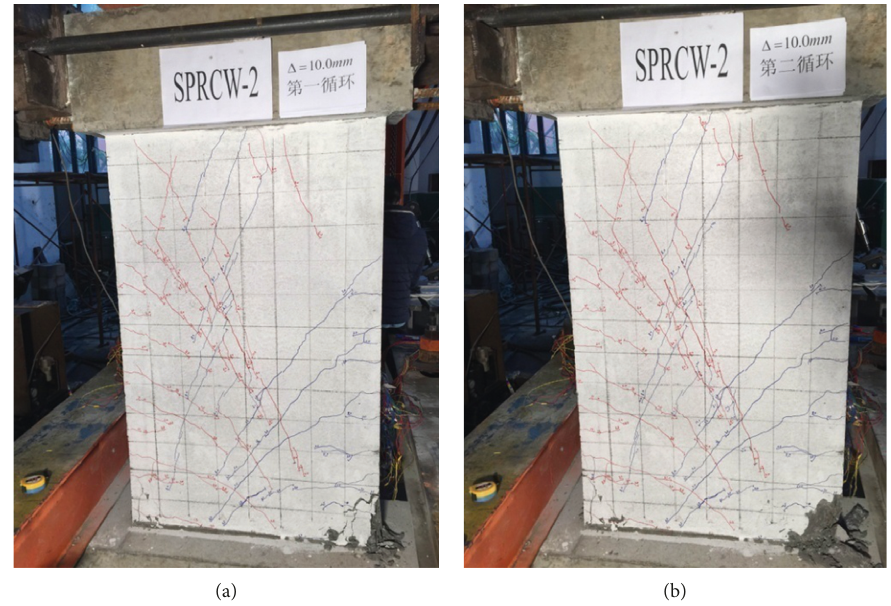
Figure 12: Diagram of cracks in the Δ � 10mm displacement cycle. (a) First cycle. (b) Second cycle.